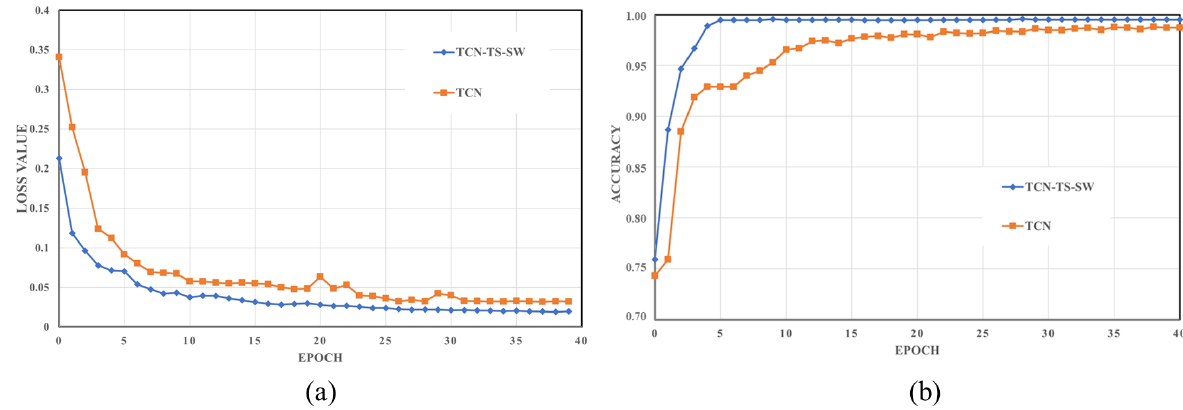
Figure 5. The effectiveness of two-stage sliding window strategy when applied to the temporal neural network architecture. ( a ) The proposed scheme’s vs TCN in terms of training loss over 40 epochs. ( b ) The effectiveness of the proposed system versus the later in terms of training accuracy.